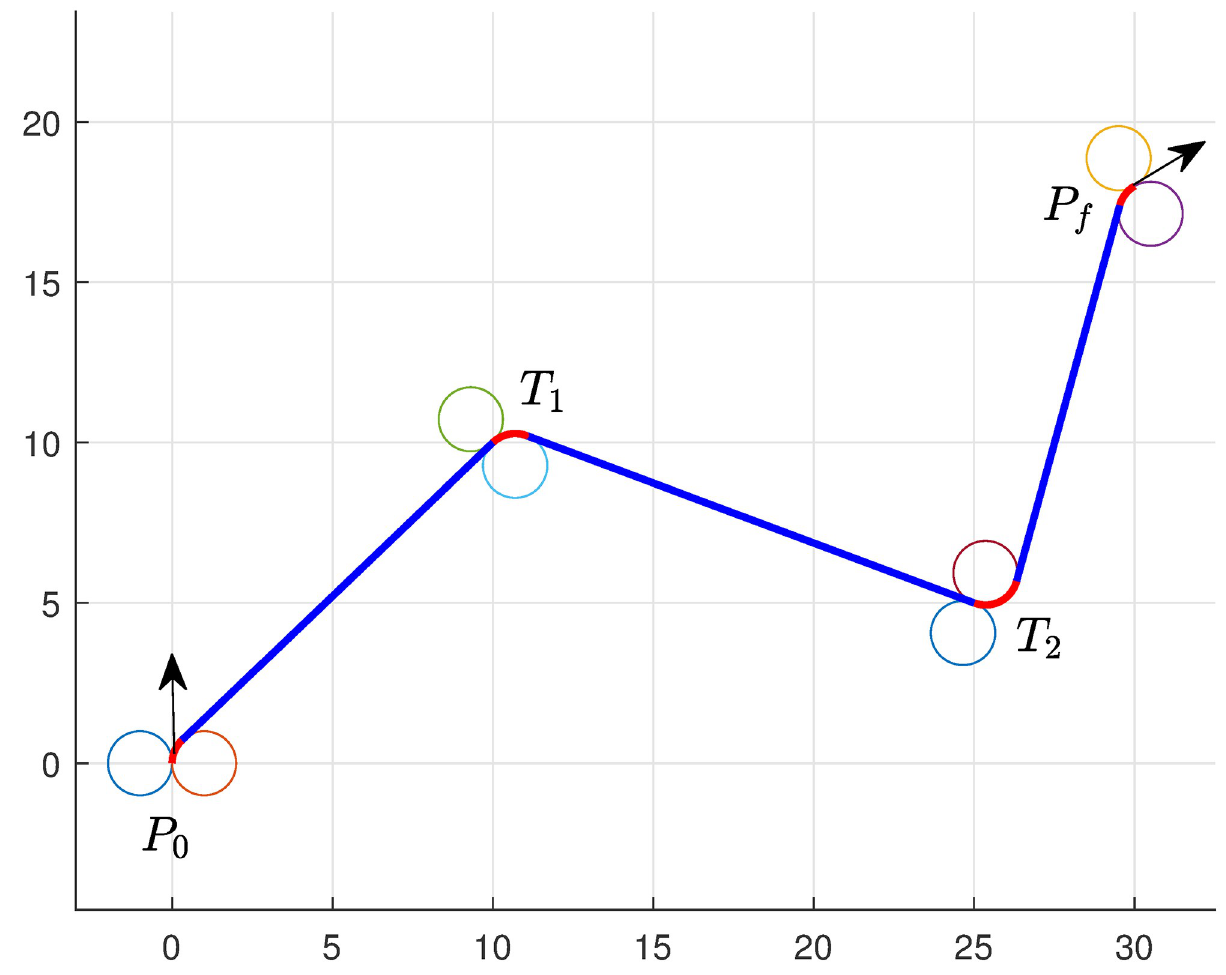
Fig 5. Minimum path approximated for Example 2 when r = 1.